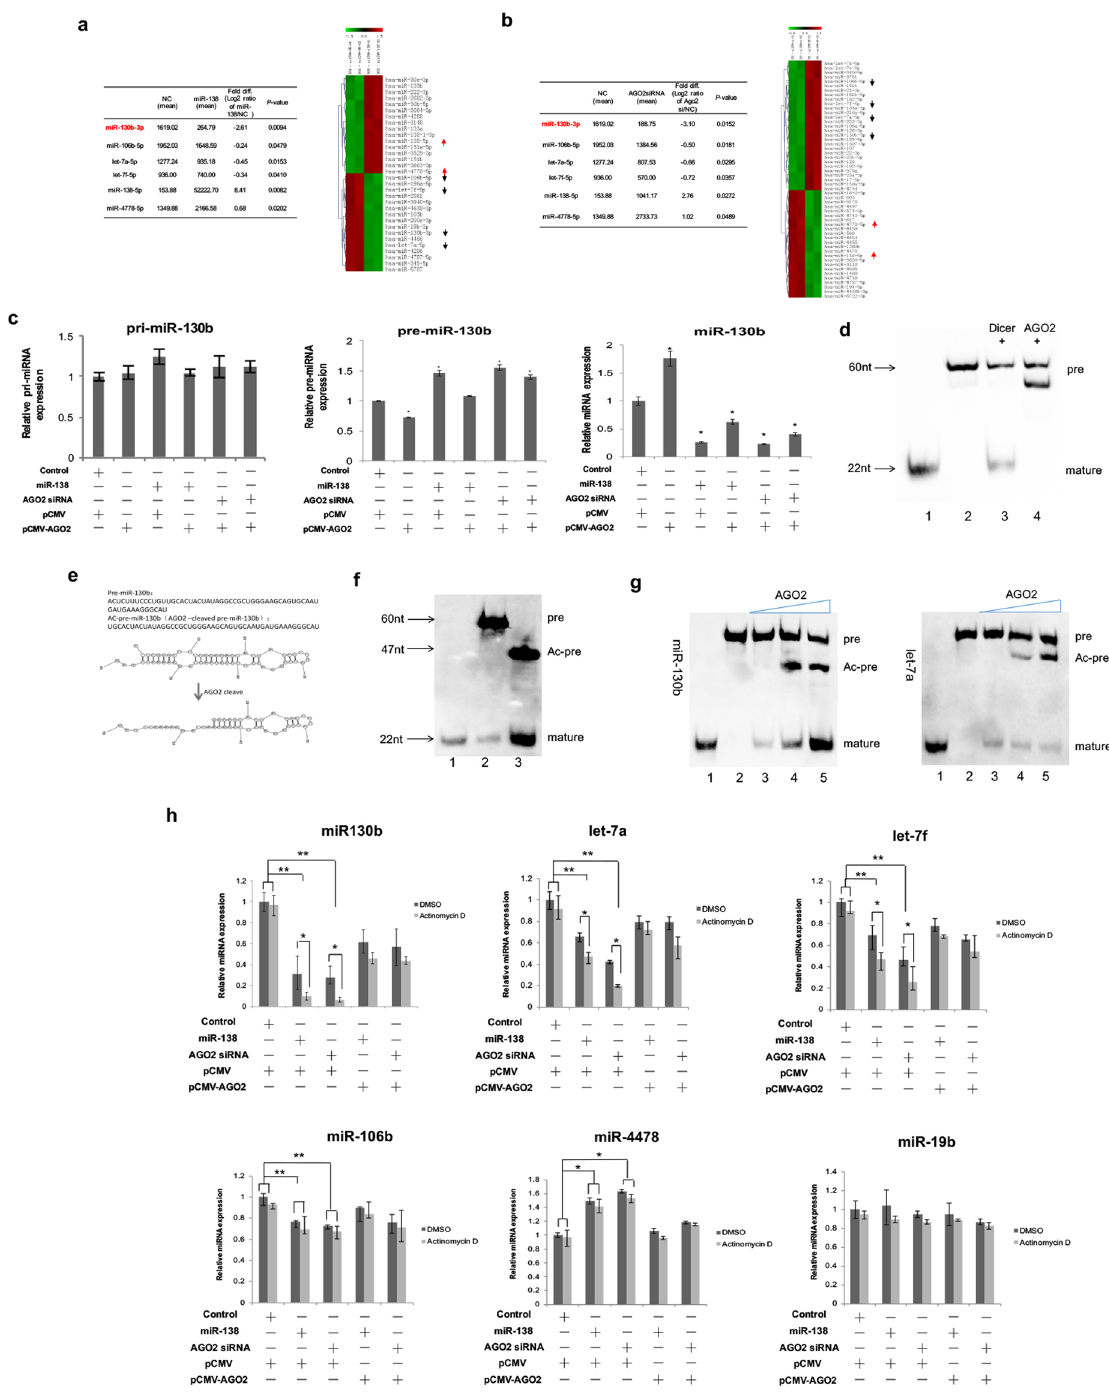
Figure 2. AGO2 affects miR-130b abundance in human NSCLC cells. The miRNAs in H1299 cells that were significantly changed in both the miR-138 and AGO2 siRNA groups vs . the negative control (top) ( a , b ). The filtered miRNA array data were subjected to unsupervised hierarchical clustering analysis. Upregulated and downregulated miRNAs are represented by red and green colours, respectively, with the common miRNAs marked with red and black arrows, respectively (bottom). ( c ) The effects of AGO2 on the biogenesis of miR- 130b. Quantitative RT-PCR assays were performed to examine the effects of AGO2 overexpression, the miR-138 mimic or AGO2 siRNA transfection on miR-130b processing. GAPDH or U6 served as an internal control. * P < 0.05 vs . NC by one-way ANOVA test. ( d ) Processing of pre-miR-130b by recombinant Dicer and AGO2 proteins in vitro . Briefly, 20 pmol of pre-miR-130b was incubated with 2 U of Dicer or 200 ng of Ago2 for 4 h. The processed products were detected using northern blotting with a biotin-labelled anti-miR-130b probe. Lane 1: 22 nt biotin-ssRNA; 2: pre-miR-130b; 3: pre-miR-130b with Dicer; 4: pre-miR-130b with AGO2. Full-length blots are in Supplementary information. ( e ) The sequence and the predicted secondary structure of Ac-pre-miR-130b. The most abundant sequence and secondary structure